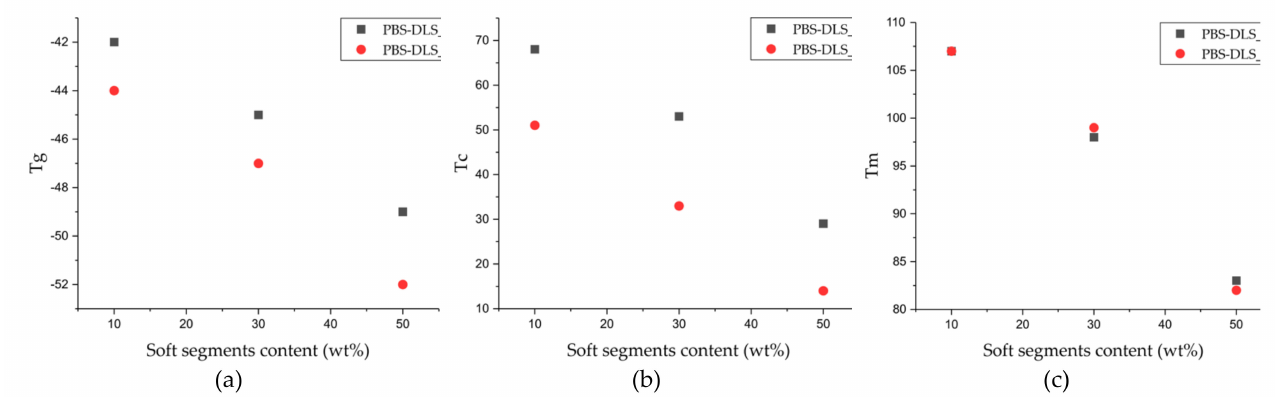
Figure 7. ( a ) Glass transition temperatures (T g ), ( b ) crystallization temperatures (T c ) and ( c ) melting temperatures (T m ) of the obtained aliphatic PBS-DLS copolyesters as a function of soft DLS segment.